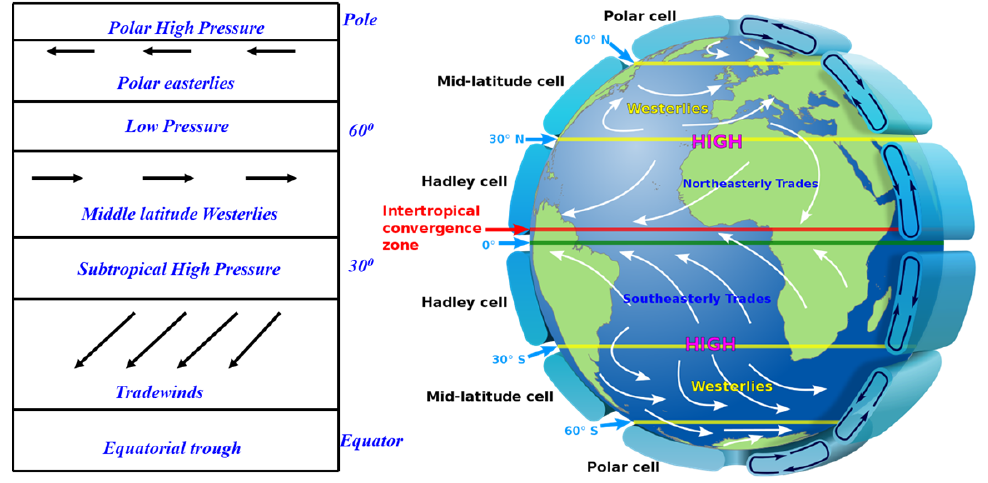
Figure 8. Representation of the wind and pressure belts at the surface [23]. The mean meridional (latitude averaged) circulation of the atmosphere between December and February and between June and August is shown in Figure 9; the values on the streamlines indicate the total mass circulation (1010 kg/s) between that streamline and zero streamline (see the details in [25]).